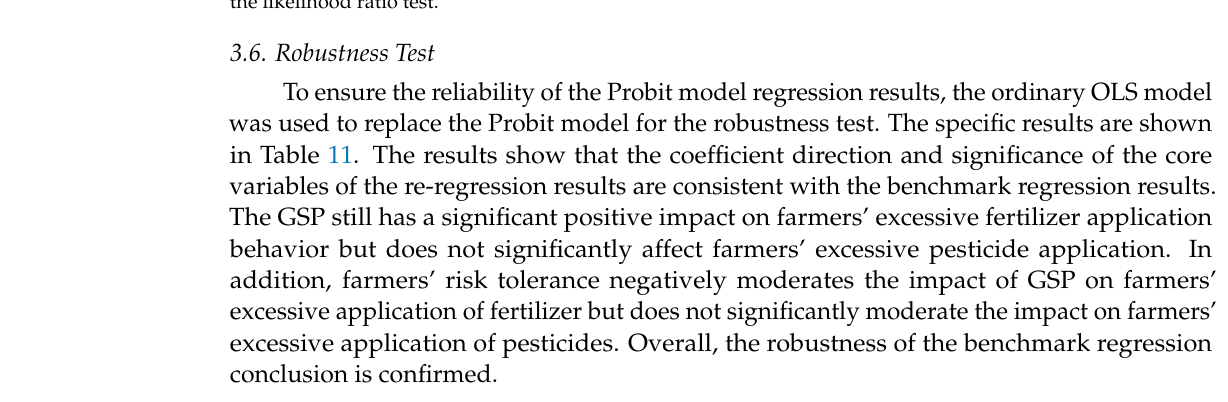
Table 11. Re-estimation results of ordinary OLS regression